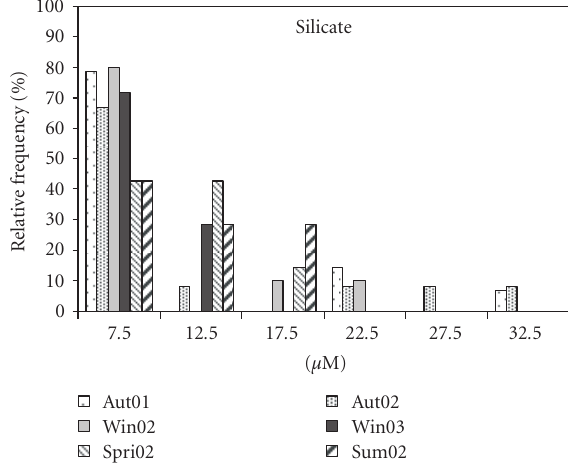
Figure 6: Silicate seasonal distributions in frequency classes (autumn 2001–winter 2003). Labels report the class lower value.